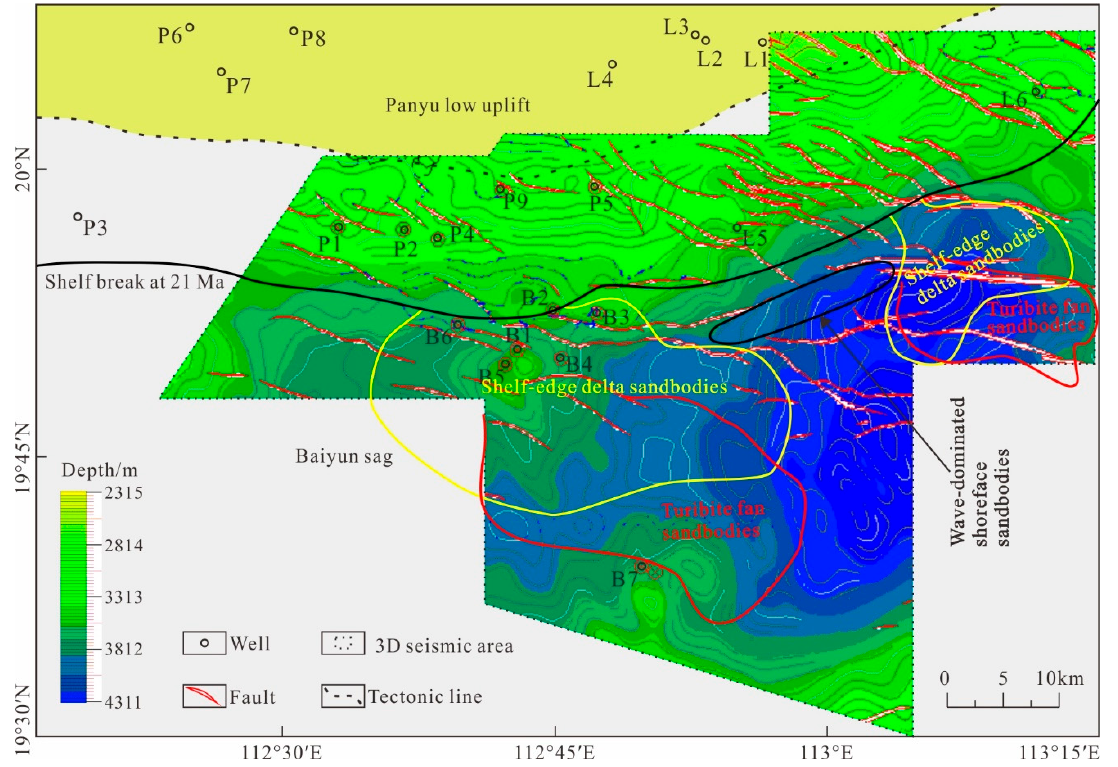
Figure 12. Relationship between sandbodies of falling stage systems tract and structural configurations. The structural contour is the depth of maximum flooding surface in the sequence SQ2. The area defined by the yellow coil is the development range of the shelf-edge delta which is determined on the basis of Figure 6A. The area defined by the black coil is the development range of the wave-dominated shoreface sands which is determined on the basis of Figure 9B. The area defined by the red coil is the development range of the turbidite fan which is determined on the basis of Figure 6B.